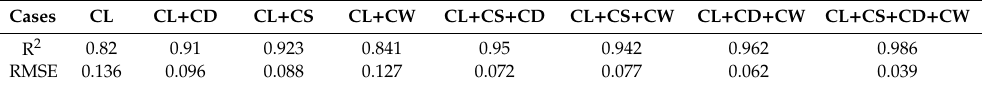
Table 1. Results of cases without stirrups and variables including corrosion level ( n = 39).